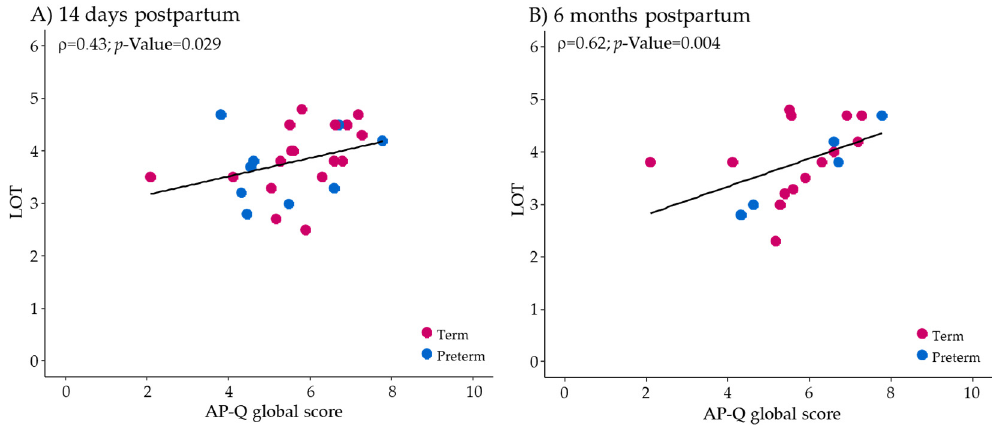
Figure 2. Correlations between the AP-Q and LOT at 14 days ( A ) and 6 months postpartum ( B ). The line represents the regression trend, the pink spots show mothers with term deliveries, and the blue spots mothers with preterm deliveries. The Spearman’s rho coefficient ( ρ ) and the p -value associated are shown in the graph.